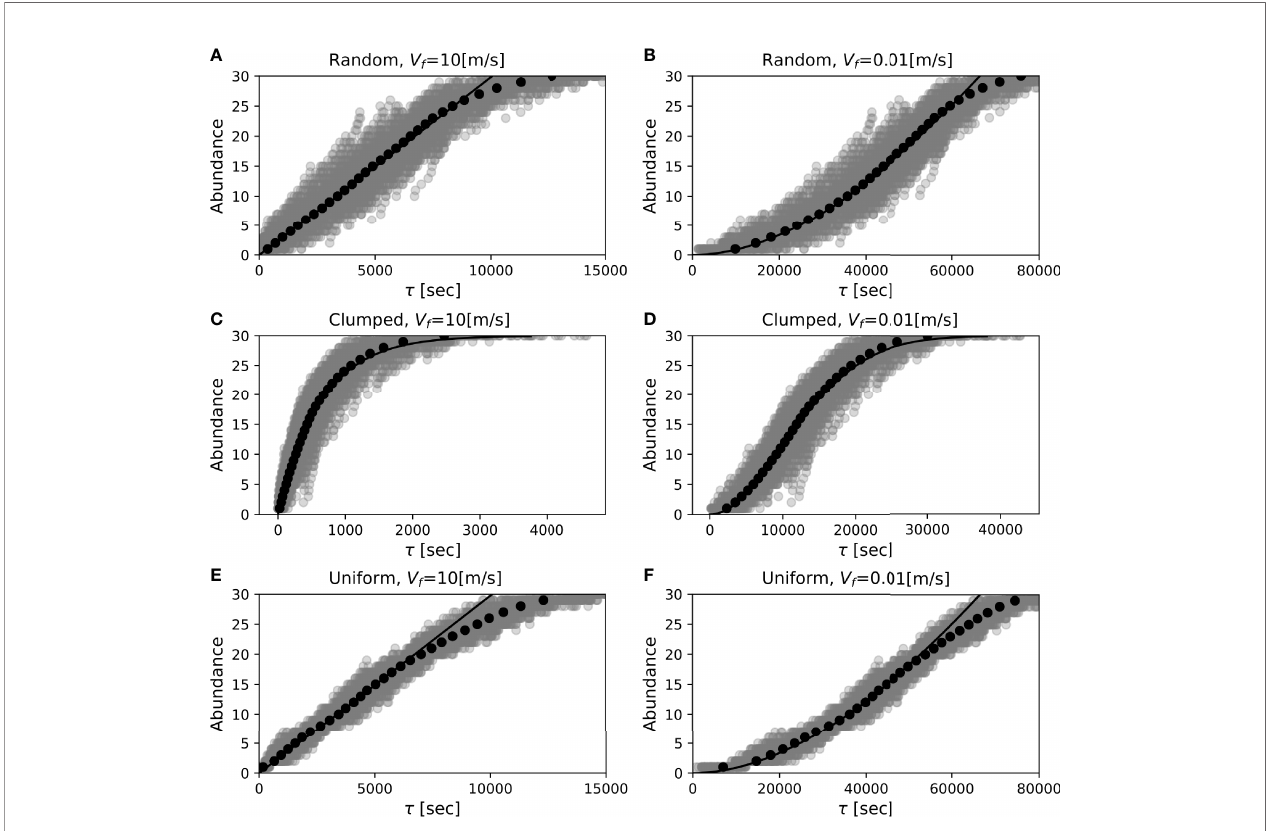
FIGURE 6 | Time pro fi les of theoretical (black curve) and simulated (dots) fi sh abundance at bait for different swimming speeds (left: V f =10 ms -1 , right: V f =0.01 ms -1 ) and different dispersion patterns (top:random; middle:clumped; bottom:uniform). The simulation is conducted under the same con fi guration as in the isotropic diffusion case in Figure 4 , except that 200 experiments are conducted. The average of the arrivals for the individuals over the experiments is shown in black dots. The diffusion coef fi cient is set to 100 m 2 s -1 in reference to the order of isopycnal eddy diffusivity (Tulloch et al.,